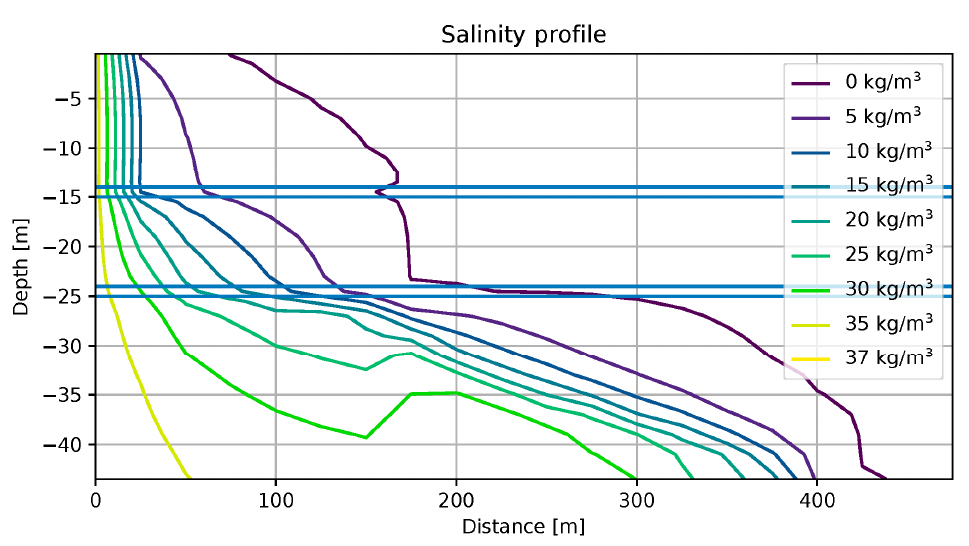
Figure 11. Concentration computed by the numerical model (black line) and electrical conductivity (coloured lines) observed at well 18.